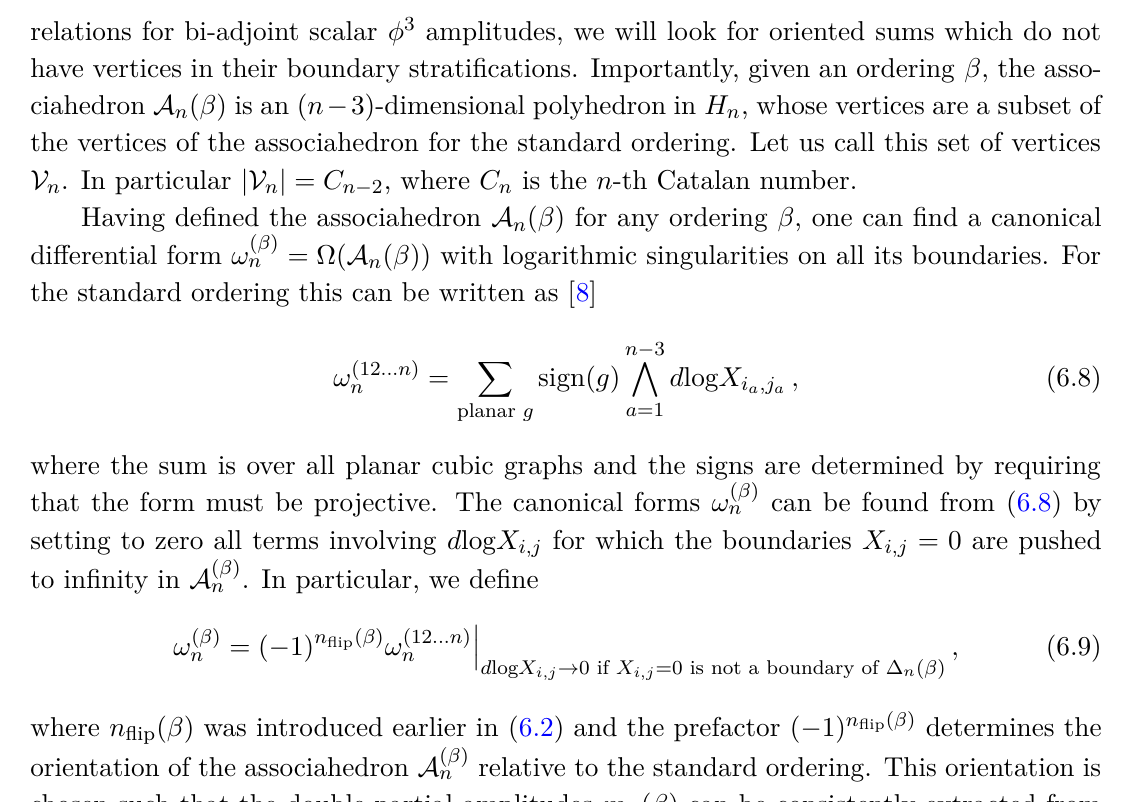
Figure 14 . Definition of the positive region ∆ 7 (1547632) . We get a partial triangulation of a regular 7 -gon with diagonals D (1547632) = { (1 , 4) , (1 , 6) , (4 , 6) } . This leads to ∆ { X 1 , 3 ≥ 0 , X 1 , 4 ≥ 0 , X 1 , 6 ≥ 0 , X 2 , 4 ≥ 0 , X 4 , 6 ≥ 0 }